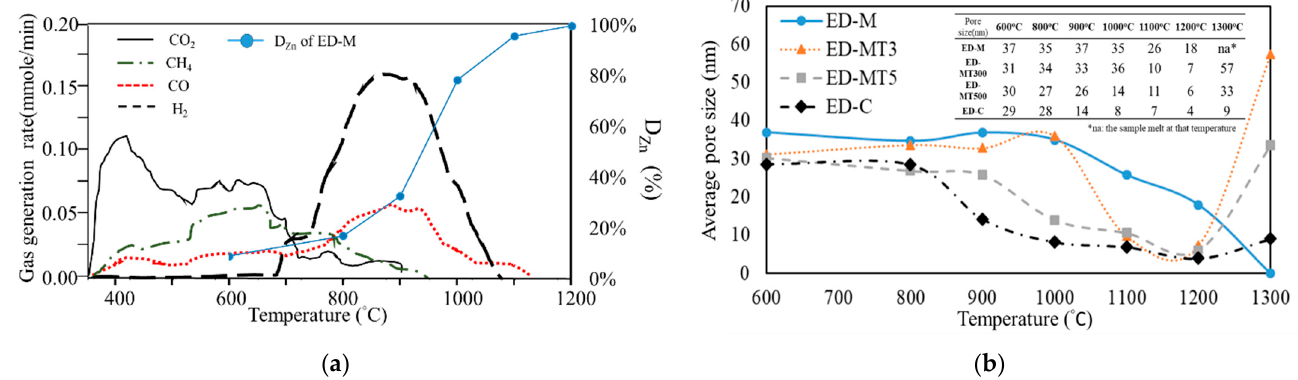
Figure 2. ( a ) Different types of gases vaporized or dissociated from volatile matter (VM) of SMS which was heated from 300 to 1200 °C at the rate of 20 °C/min in inert gas; for comparison, the degree of Zn removal (D Zn , %) is also plotted. ( b ) Changes in mean pore size in the carbothermic reduction process from 600 °C to 1300 °C of samples with C/O ratio = 0.8.